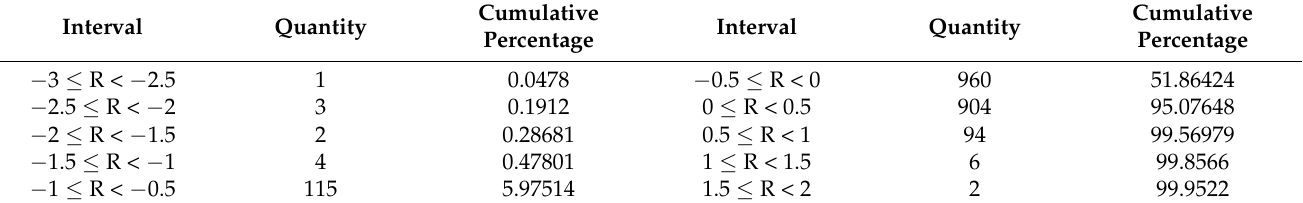
Figure 11. Distribution map of residual value under normal working conditions.